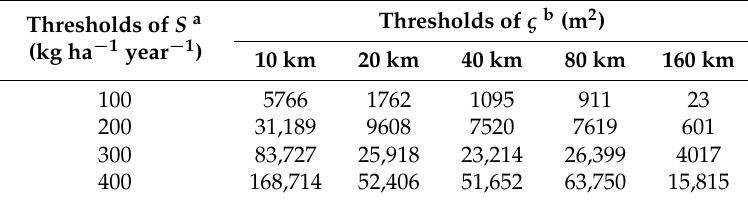
Table 3. Threshold setting for the sill value ς of the DEM semi-variogram.